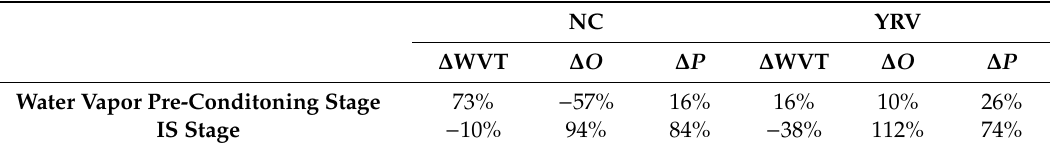
Table 2. Percentage of ∆ WVT, ∆ O, ∆ P during water vapor pre-conditioning stage (time step − 24 to 0) and during the IS stage (time step 0 to 48) accounting for the total precipitation during the whole period (time step − 24 to 48) for the ISEs in NC and the YRV region. NC YRV ∆ WVT ∆ O ∆ P ∆ WVT ∆ O ∆ P Water Vapor Pre-Conditoning Stage 73% −